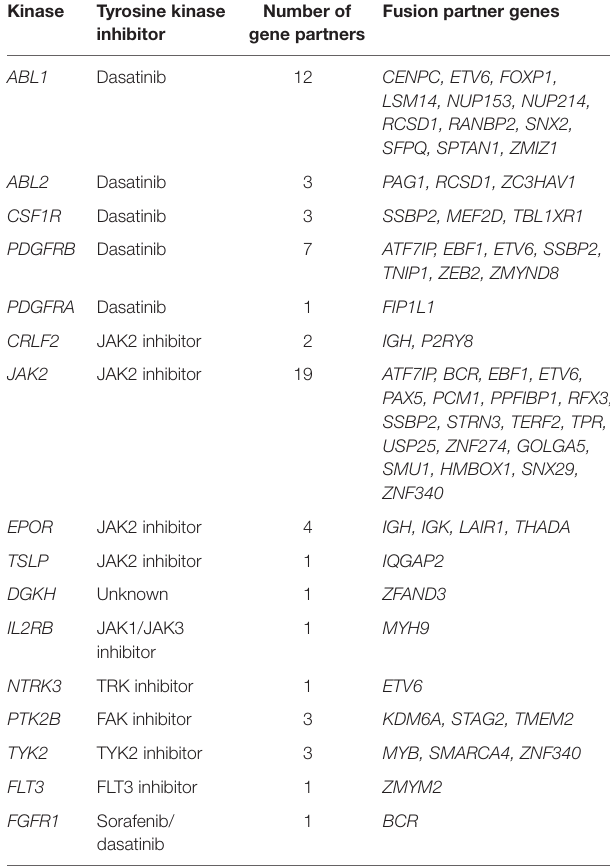
tABLe 1 | Representative kinase rearrangements and therapeutic targets in Ph-like ALL. a